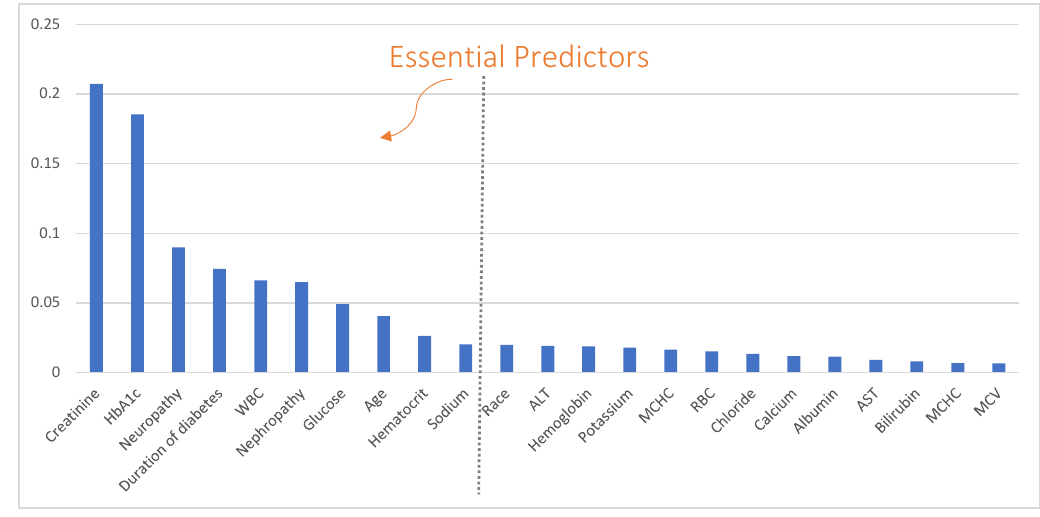
Figure 4. Variable importance and essential predictors returned by the ensemble predictor selection (EPS) method.